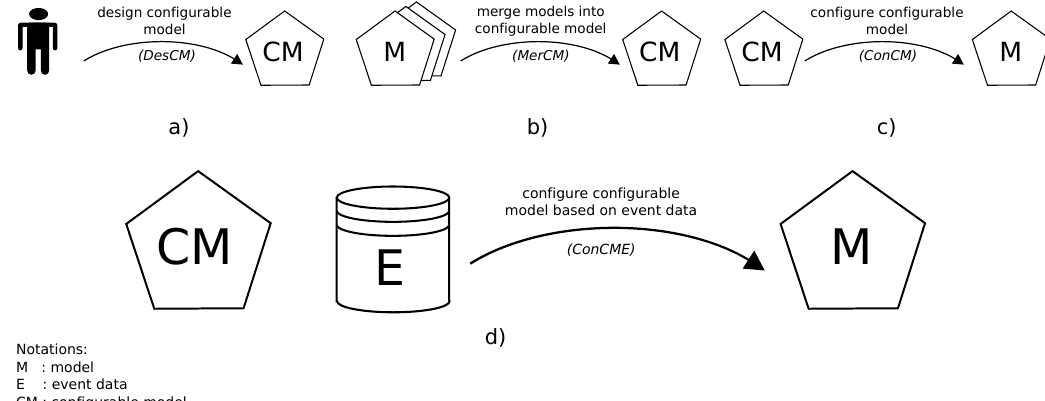
Figure 1. Business process management (BPM) use cases [7] related to configurable process models: ( a ) manually design a configurable process model (DesCM), ( b ) merge the collection of process models to generate a configurable process model (MerCM) and ( c ) configure a configurable process